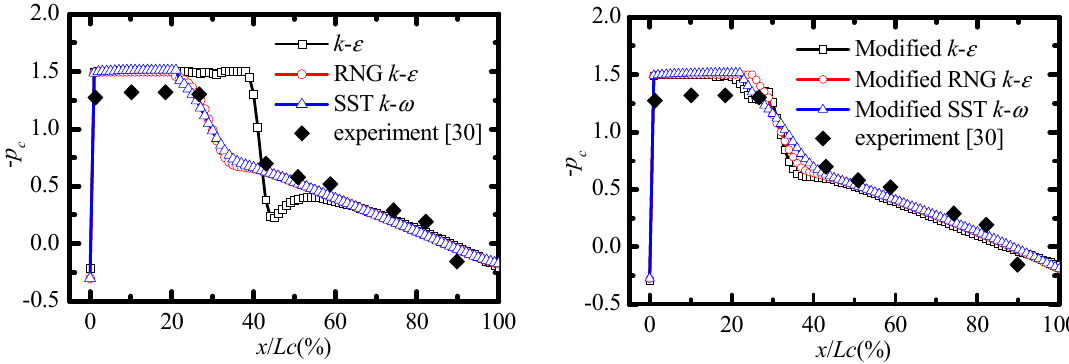
Figure 6. Pressure coefficient distribution of the NACA0015 hydrofoil at 25° С .